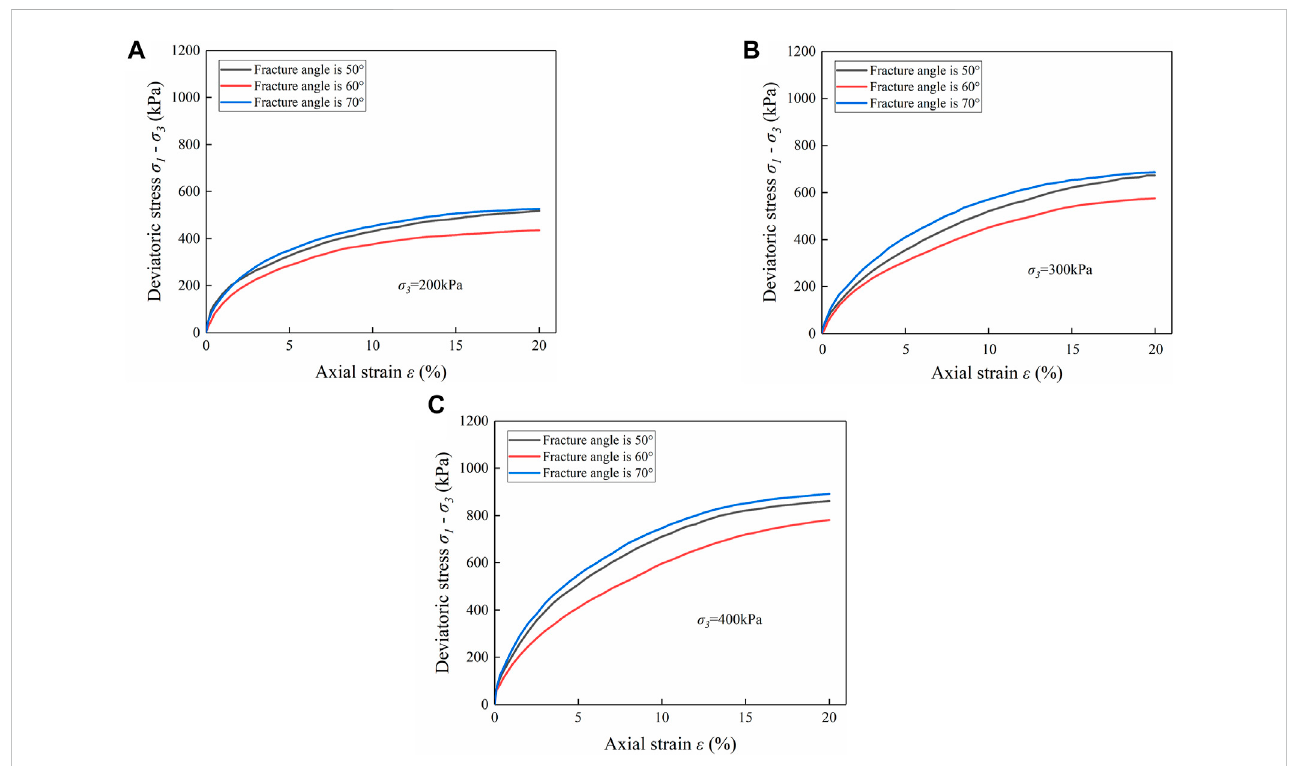
FIGURE 4 Deviator stress versus axial strain of loess with different fractured angles: (A) σ 3 =200kPa; (B) σ 3 =300kPa; (C) σ 3 =400